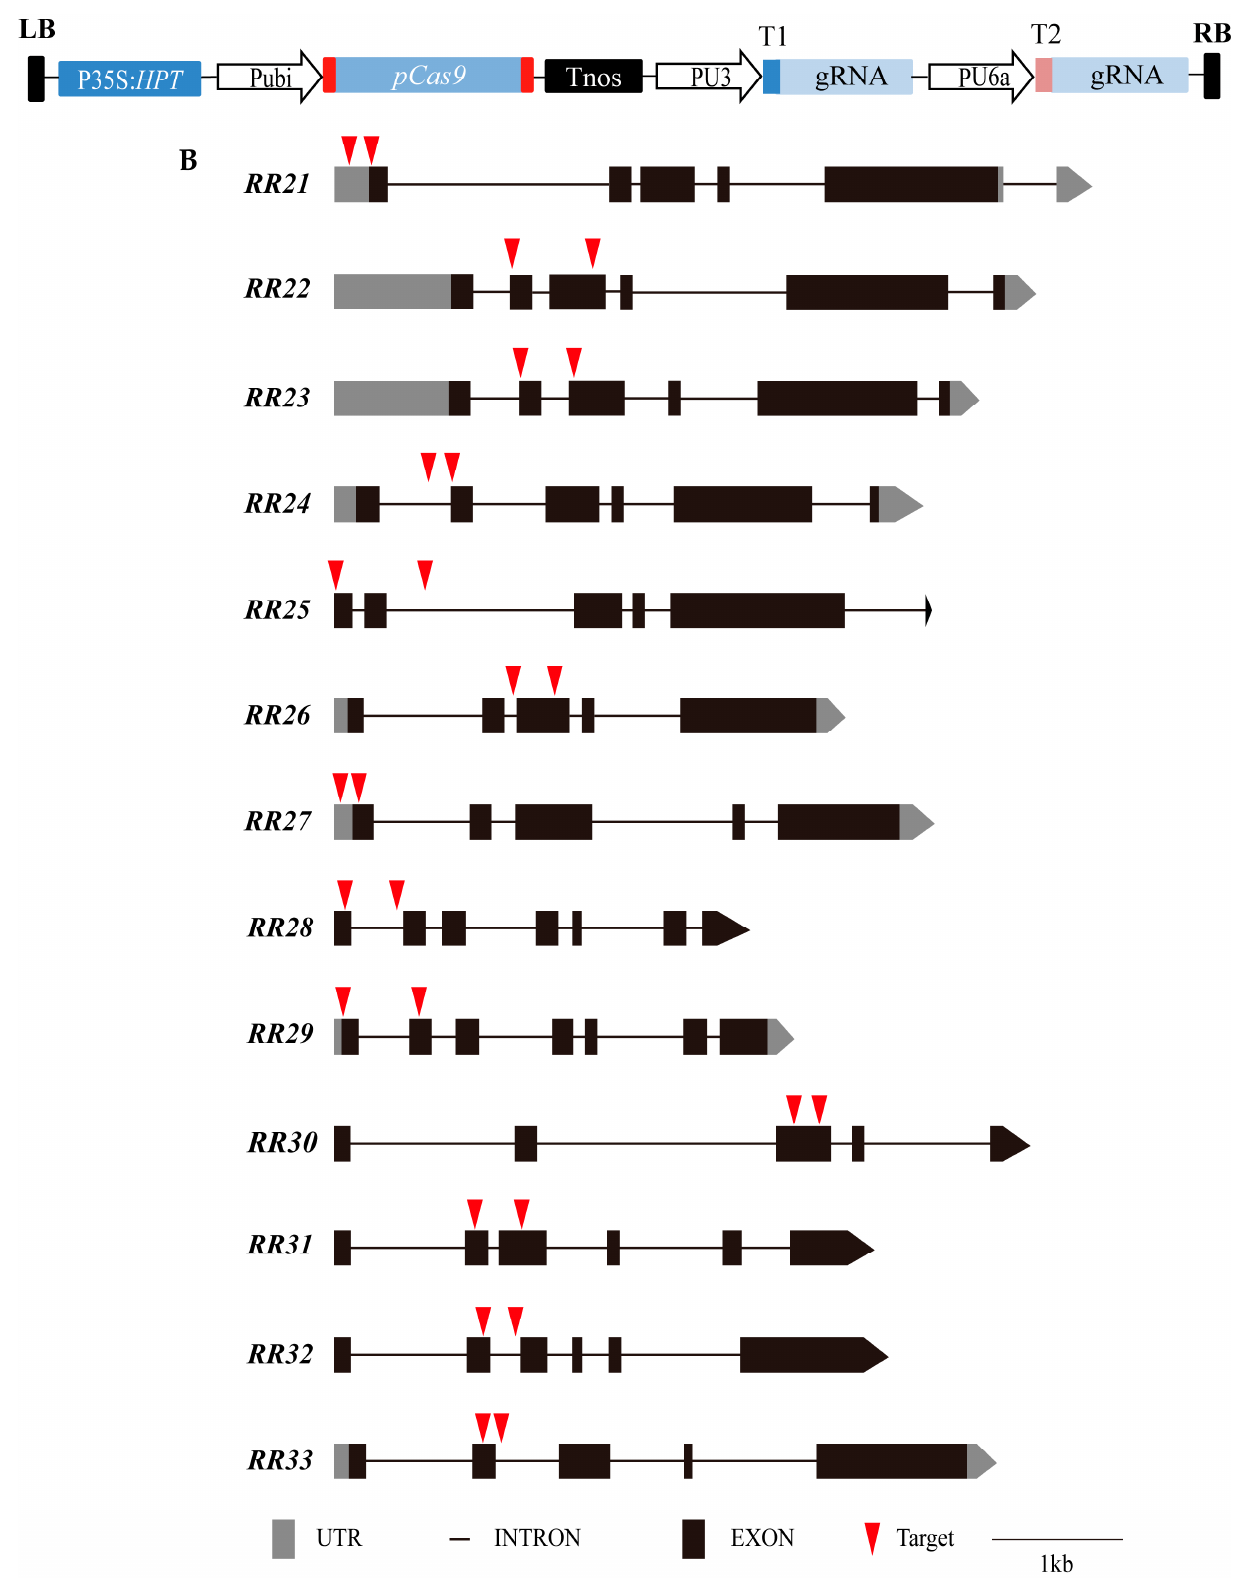
Figure 4. Diagram of CRISPR/Cas9 construction and distribution of targets on OsRRs . ( A ) . Diagram of CRISPR/Cas9 construction. ( B ). Distribution of targets on type-B OsRRs . Table 2. Summary of genome editing results in T 0 transgenic rice by PCR.